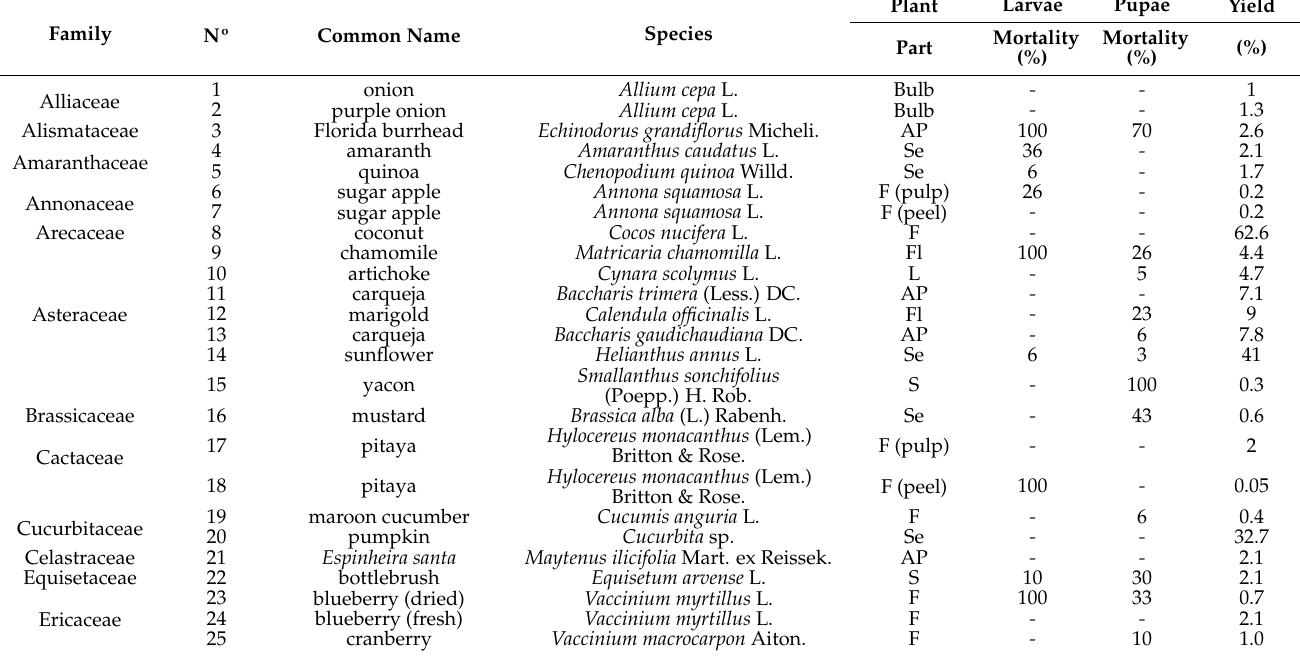
Table 1. Larvicidal/pupicidal activity (250 µ g/mL, 24 h) and yield of extracts produced by accelerated solvent extraction